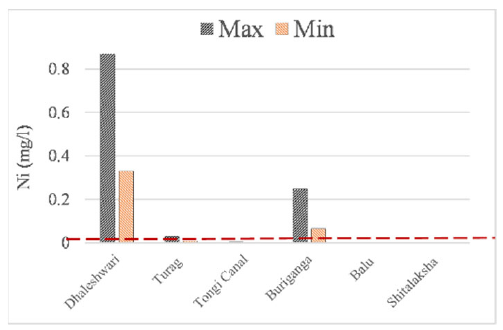
Figure 12. Concentrations for Ni in the peripheral rivers of Dhaka with WHO standard in dotted line (0.003 mg/L).